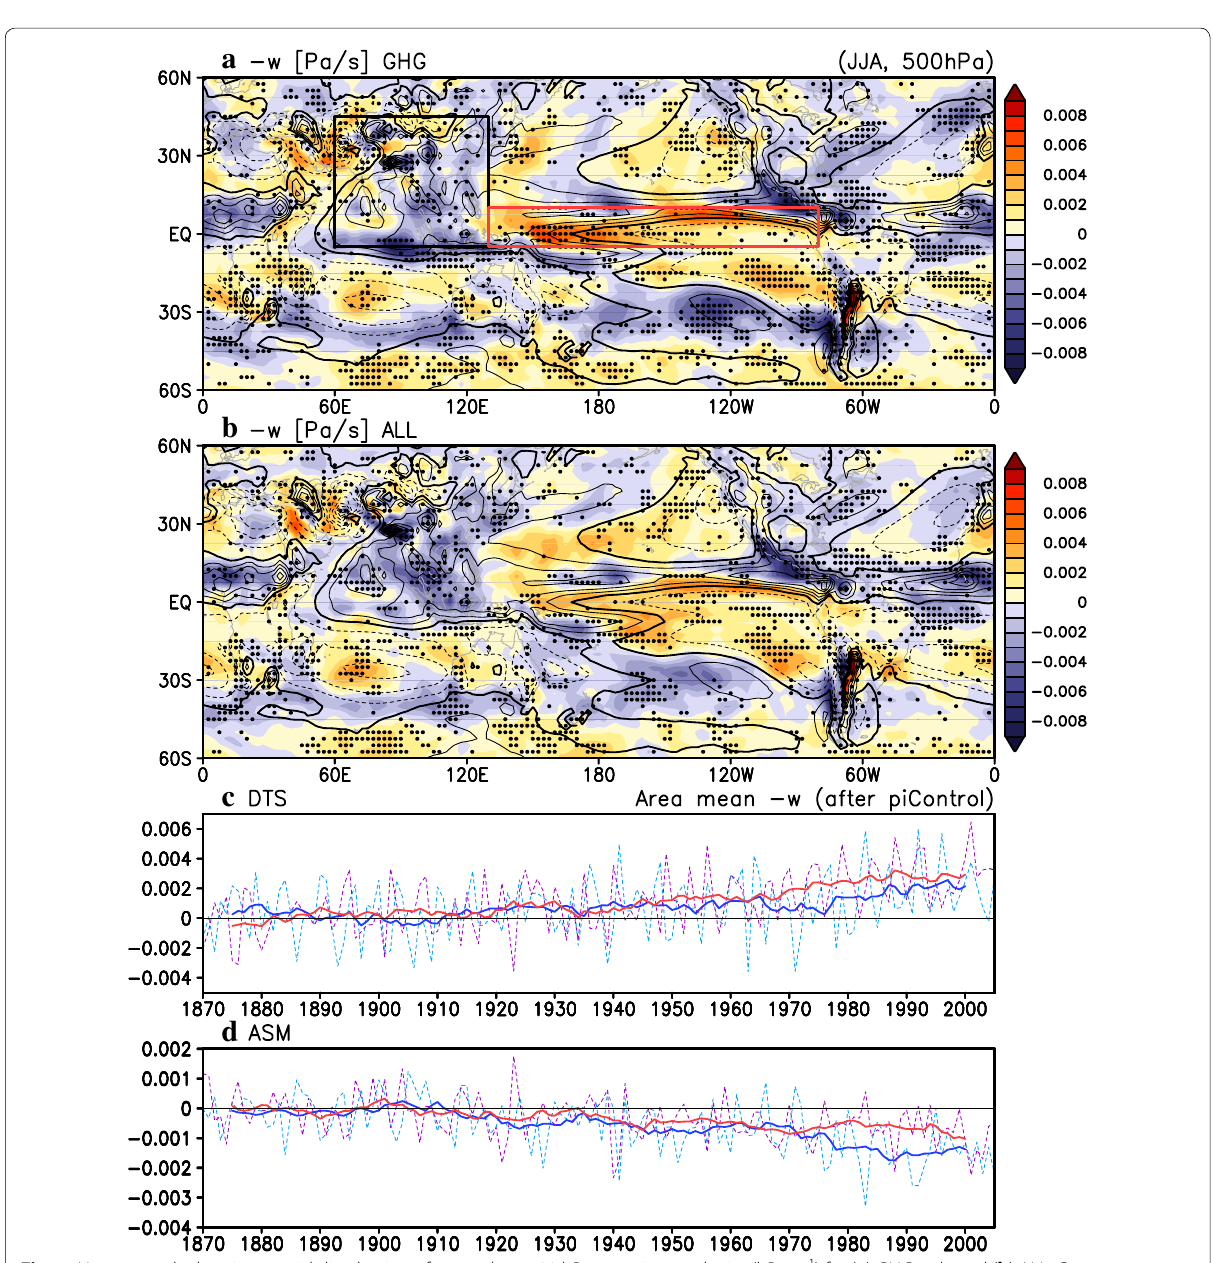
Fig. 1 Upper panels showing spatial distribution of anomalous 500 hPa negative p ‑velocity (hPa s − 1 ) for ( a ) GHG only and ( b ) ALL. Contours indicate pre‑industrial climatology, with positive (warm color) and negative (blue color) values indicating anomalous ascending and descending motions, respectively. Grid points where 12 or more out of 19 models agree in the sign of the anomaly are indicated by black circles. Lower panels showing time series (1870–2005) of negative p‑velocity averaged over ( c ) the DTS domain (rectangle outlined red) and ( d ) the AMS domain (rectan‑ gle outlined black), for GHG (red line) and ALL (blue line) respectively. Thick lines indicate 5‑year running